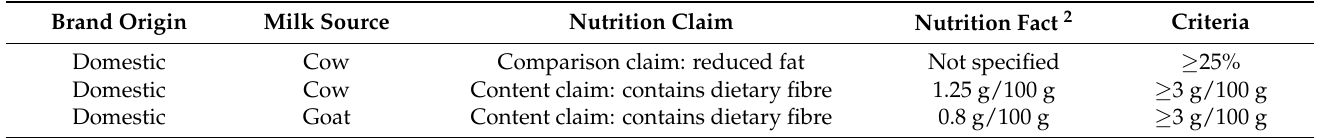
Figure 6. Number of milks targeting Chinese older adults made nutrition claims on specific nutrients that appeared on at least 5% of all products and the level of compliance. 1 GB 28050-2011 is the Food Safety National Standards for nutrition labelling of pre-packed foods issued by Ministry of Health of People’s Republic of China. Table 8. Products failing to comply with GB 28050-2011 1